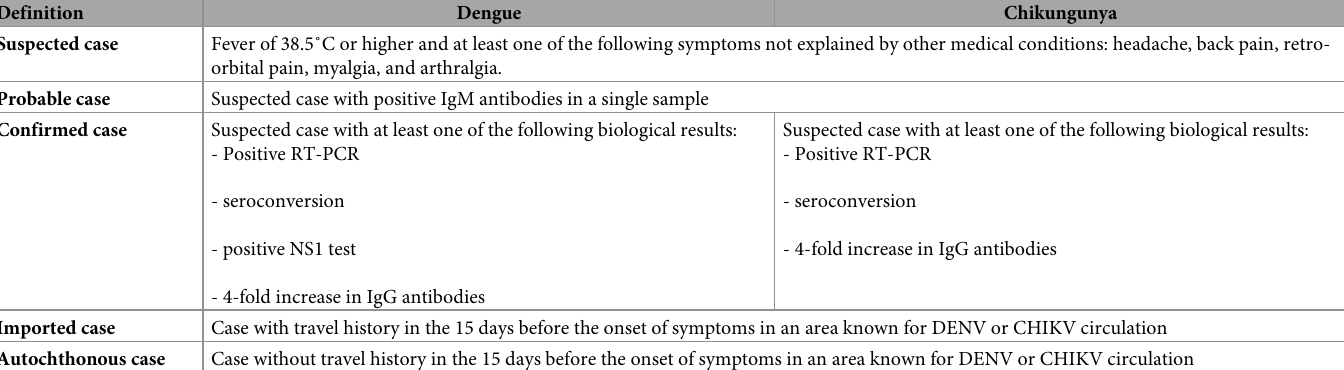
Table 1. Case definitions for dengue and chikungunya virus